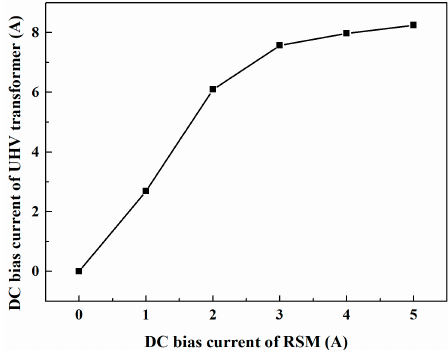
Figure 8. The equivalent relationship of DC bias current of the UHV and RSM. Table 3. Equivalent relationship of DC bias current of RSM to UHV.